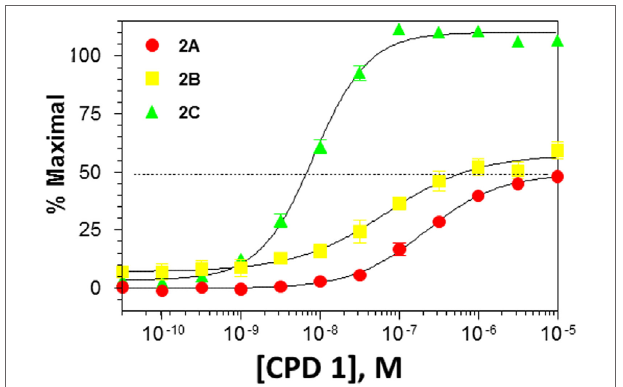
FigUre 1 | Functional activity of cPD1 at 5-hT 2a,B,c receptors . Data are from experiments conducted with n = 15. Each data point represents the mean ±